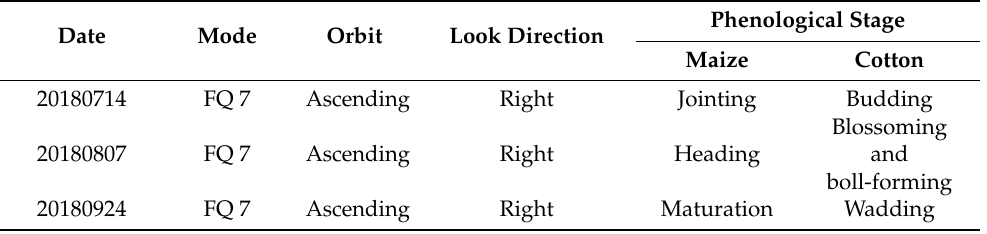
Table 1. Description of the acquired RADARSAT-2 polarimetric synthetic aperture radar (PolSAR) data.